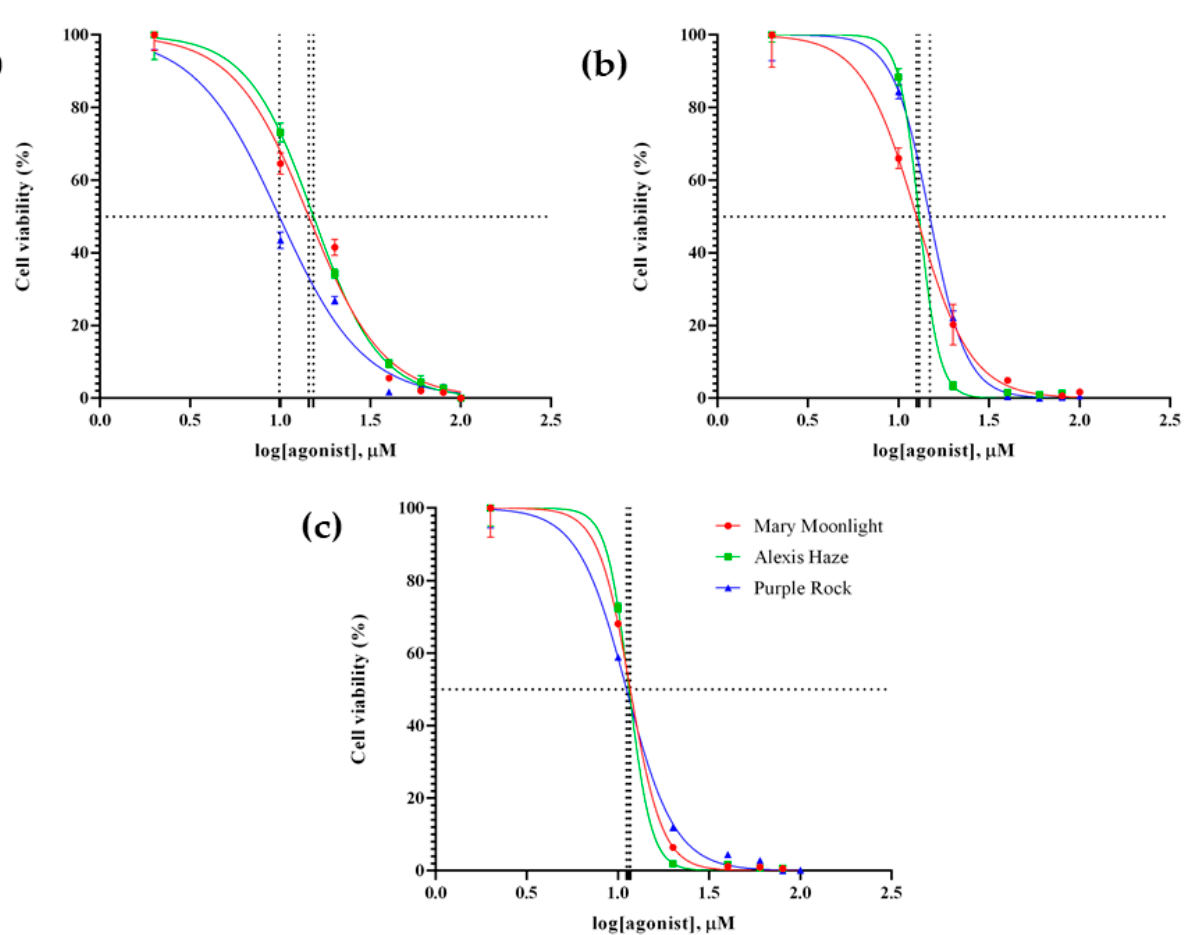
Figure 3. Dose–response curves of Mary Moonlight-Legal Weed, Alexis Haze-Legal Weed, and Purple Rock-Legal Weed extracts. HepG2 cells were grown for 24 h ( a ), 48 h ( b ), 72 h, and ( c ) in the presence of increasing concentrations of the three extracts. The viability of cells was evaluated using the MTT assay and the concentration required to reduce the cell number by 50% (IC 50 ) for each condition was calculated using GraphPad Prism. Each data point represents the mean of at least three separate experiments and the vertical bars represent the S.D. Table 4. IC 50 of Mary Moonlight, Alexis Haze, and Purple Rock against HepG2 cells as determined by the MTT assay.